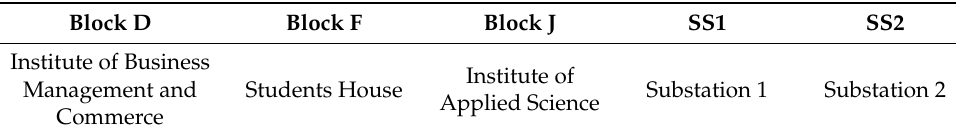
Figure 2. MCAST micro-grid—Electrical Network . Currently, the DERs of the electrical system are made up of 63.24 kWP of PV systems. These are distributed on the three buildings, having 21.12 kWP each on both Blocks J and D and 21 kWP on Block F [12]. We propose enhancing the reliability of the micro-grid with a battery energy storage system (BESS) so that the micro-grid system will be able to isolate for a period of time partially. The current MCAST micro-grid is planned to work in par- allel to the main grid, but a simulation framework is developed to observe the system’s behavior when diesel generators and BESS are integrated within the system. In the MCAST micro-grid system architecture, there is only one point where the main grid meets with the system at PCC. The ultimate aim is for the micro-grid to isolate from the main grid even if it means that the controller has to shed non-critical loads to save